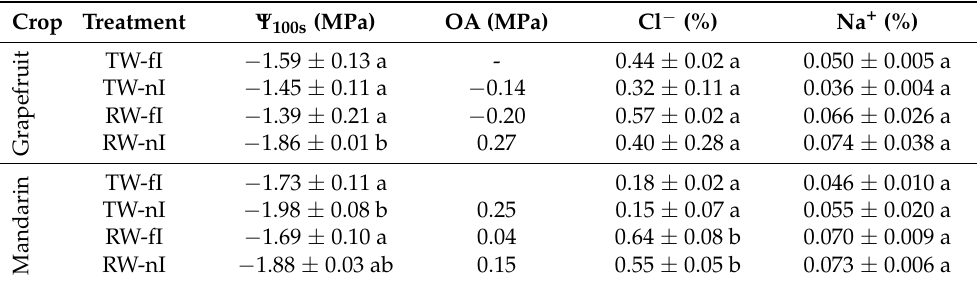
Table 1. Leaf osmotic potential at full turgor ( Ψ 100s ) at midday, osmotic adjustment (OA), and leaf phytotoxic element values for each treatment and crop (grapefruit and mandarin). Each value is the average ± standard deviation of 4 blocks collected at 248 DOY. Within each column, different letters indicate significant differences at p < 0.05, as assessed using Tukey ´ s test.